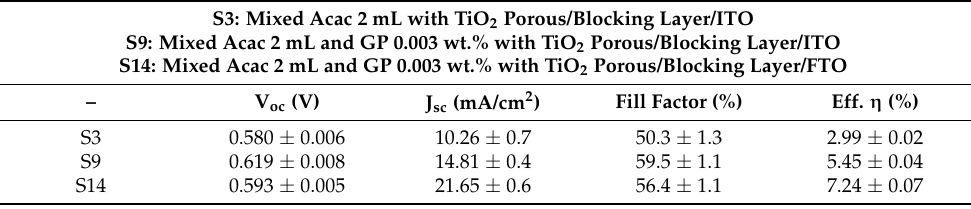
Figure 15. Current–voltage characteristics of the DSSC photovoltaic efficiency, replace the ITO with FTO/glass. Table 4. DSSC photovoltaic efficiency, replacing the ITO with